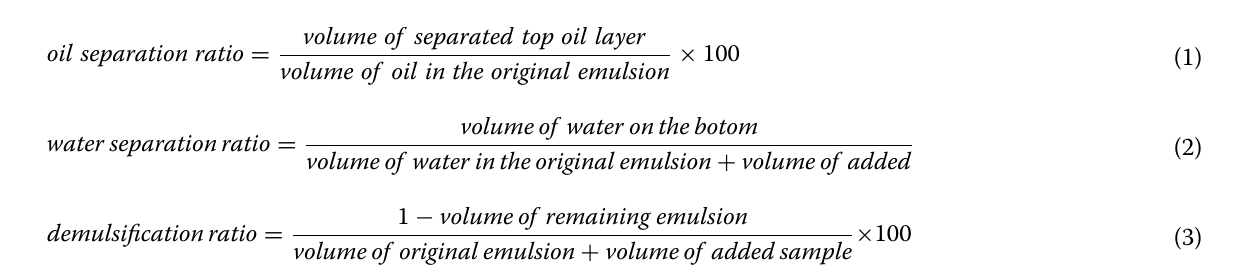
oil separation ratio =